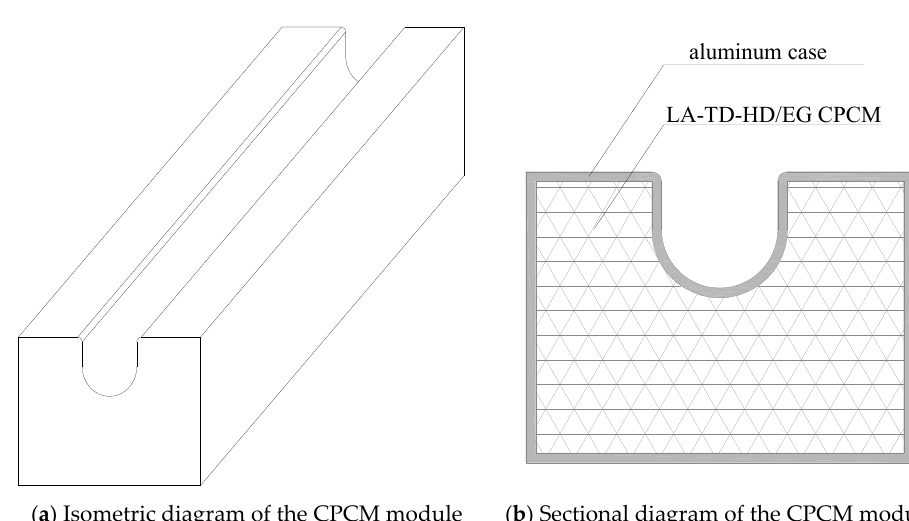
Figure 4. Structure of the CPCM modules in the radiant floor heating terminal.